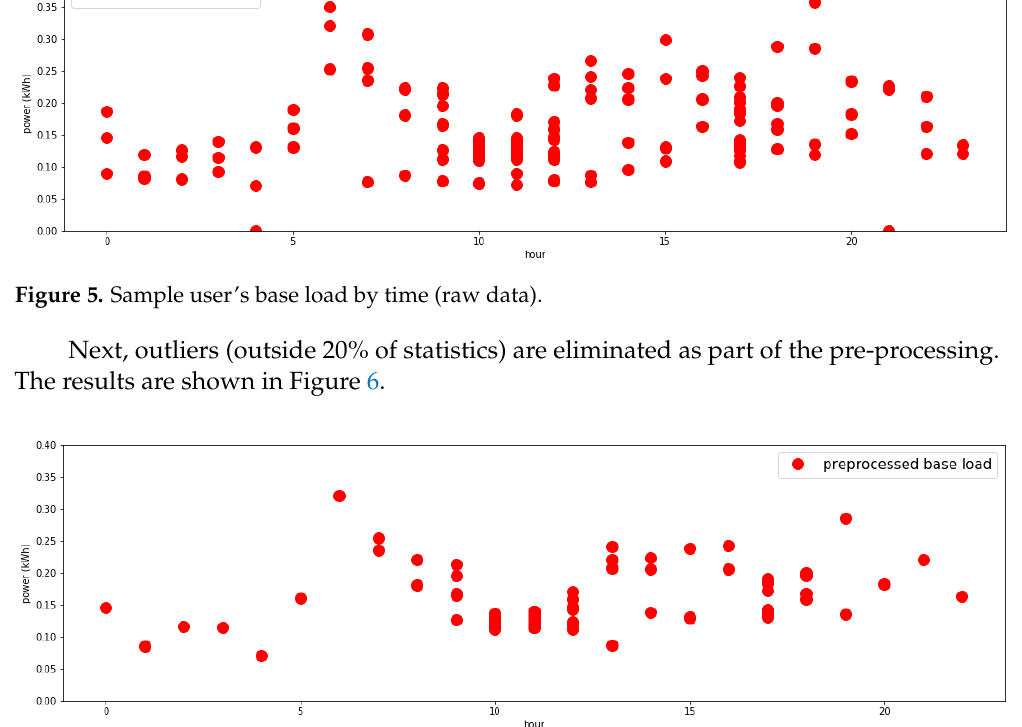
Figure 6. Sample user’s base load by time (pre-processed).